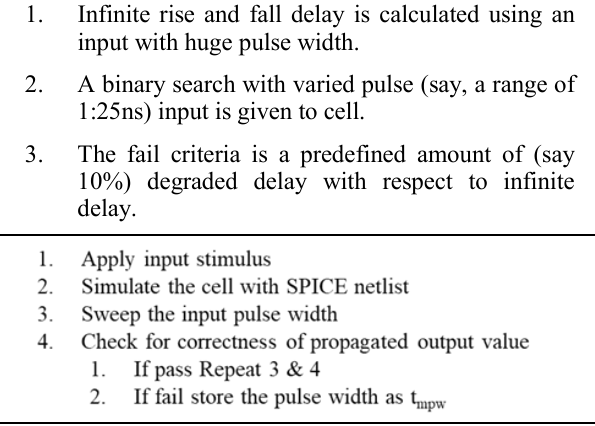
Figure 6. Characterisatin pseudocode for minimum pulse